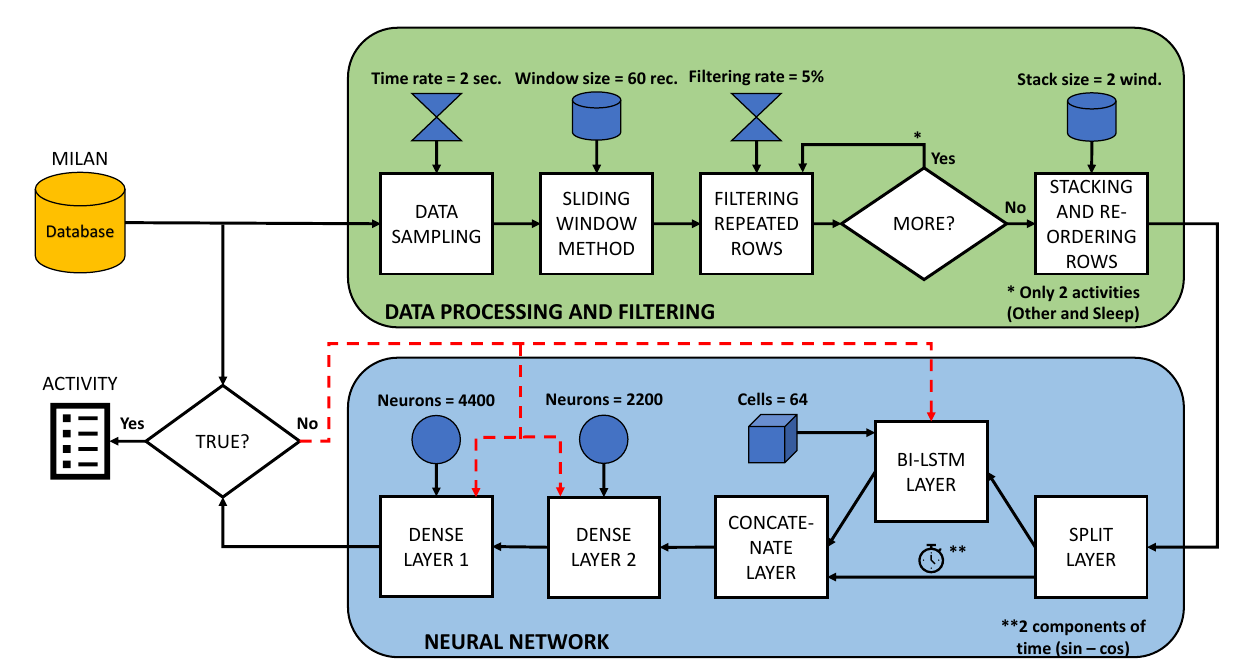
Figure 5. Block diagram of the system